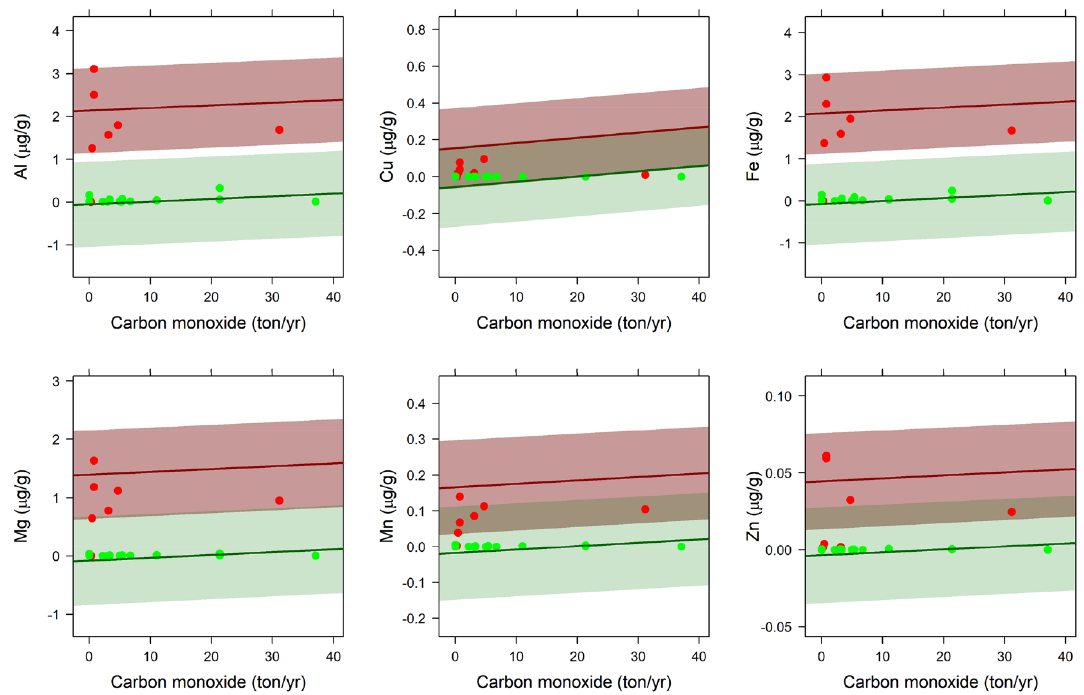
Figure 3. Concentration (standardized values) of trace elements as a function of carbon monoxide (CO) averaged at 20 km around sampling points, as predicted from supported GLM (Table 3). Predictions and observed values are shown separately for sampling points located at the northern (red line and points) and southern (green line and points) regions, as well as 95% confidence intervals are shadowed in red and green,